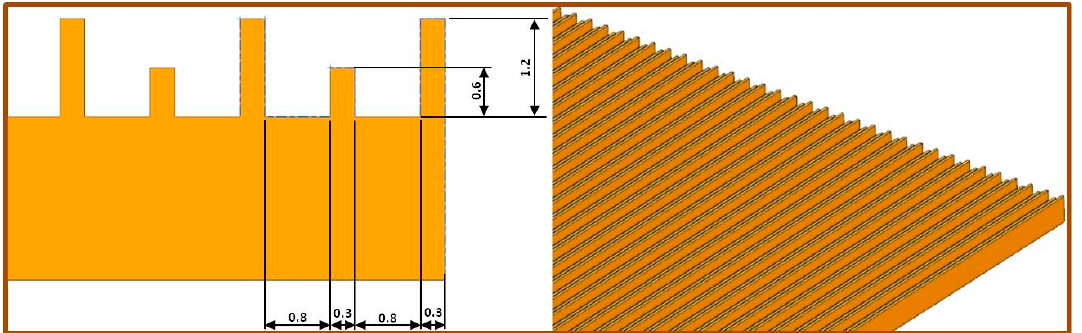
Figure 1. 3D printed collector geometry—NX sketch.